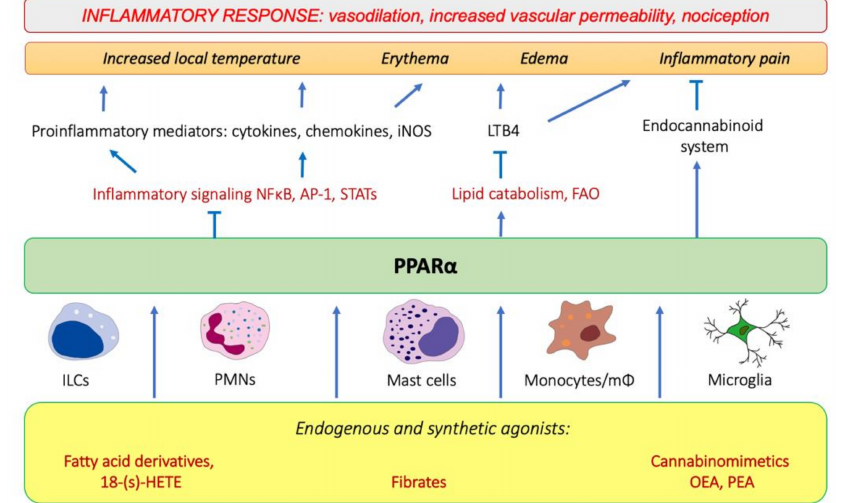
Figure 1. The involvement of PPAR α in the modulation of inflammation through interfering with the main inflammatory transcription factors (NF- κ B, nuclear factor κ B; AP-1, activation pro- tein 1; STATs, signal transducers and activators of transcription) through activating lipid catabolic pathways and participating in the endocannabinoid system (see Section 7). iNOS, inducible ni- tric oxide synthase; FAO, fatty-acid oxidation; LTB 4 , leukotriene B 4 ; OEA, oleylethanolamide; PEA,